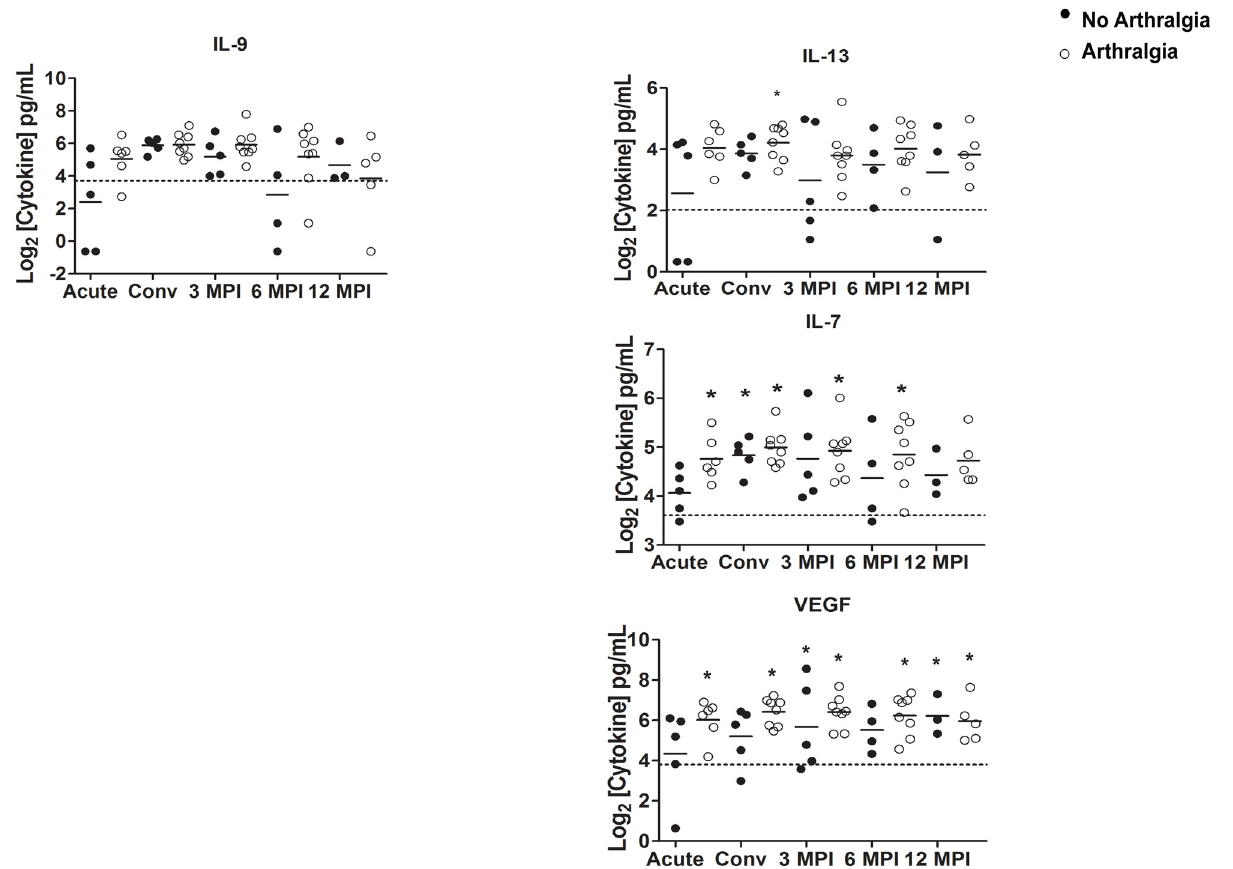
Fig 4. Cytokine/chemokine immune mediators in MAYV-infected subjects and potential predictors of MAYV-induced long-term arthralgia. At the acute visit as well as the convalescent visit (20 ± 10 days), at 90 ± 10 days, at 180 ± 15 days, and at 360 ± 30 days after the acute visit, cytokine concentrations of subjects with (open circles) or without (closed circles) persistent arthralgia were compared to healthy donor controls as well as between MAYV-infected groups by a 2-tailed Mann-Whitney test. An asterisk ( * ) indicates statistical significance (p < 0.05) when compared to healthy controls. The horizontal dotted line represents the median cytokine values for the healthy donor controls. Each circle corresponds to the cytokine concentration of an individual subject and the solid horizontal line represents the mean cytokine concentration of the group. Levels of IL-9 were not significantly different when compared to the healthy control group. Immune mediators on the right are potential predictors of MAYV-induced long-term arthralgia.